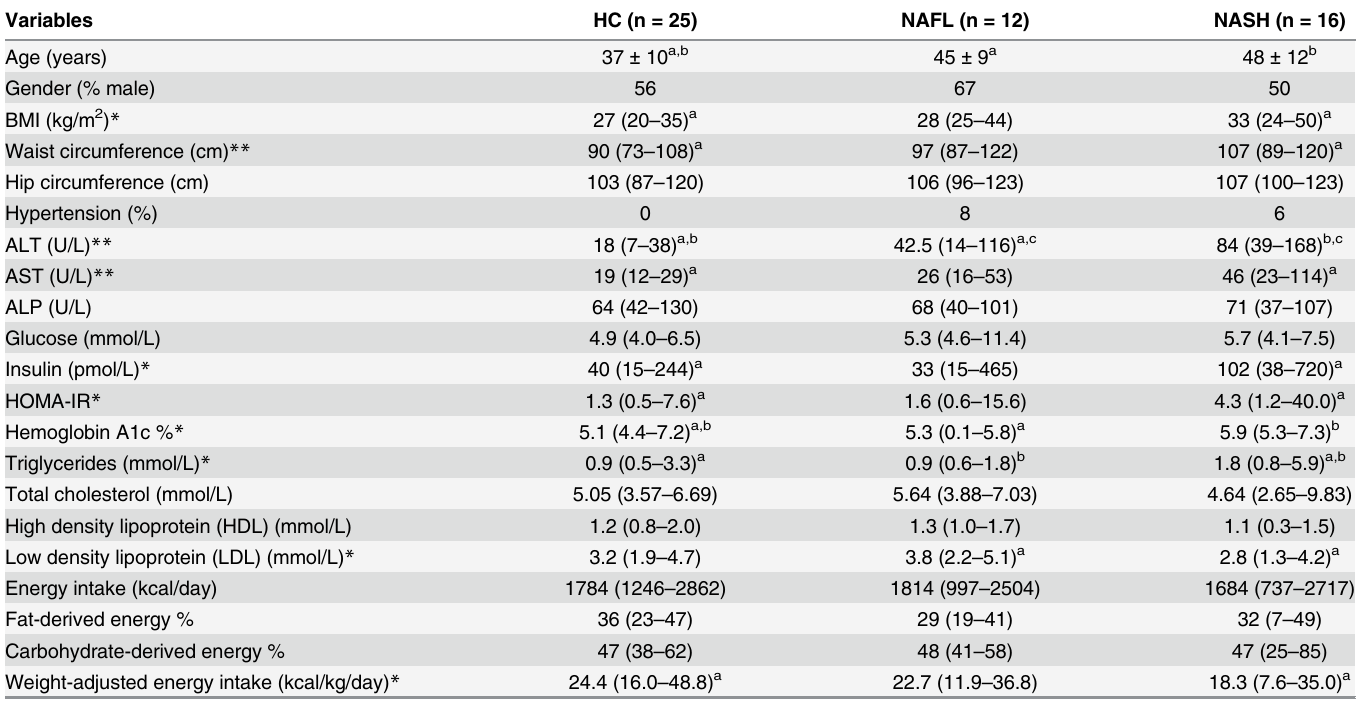
Table 1. Demographic and laboratory results.